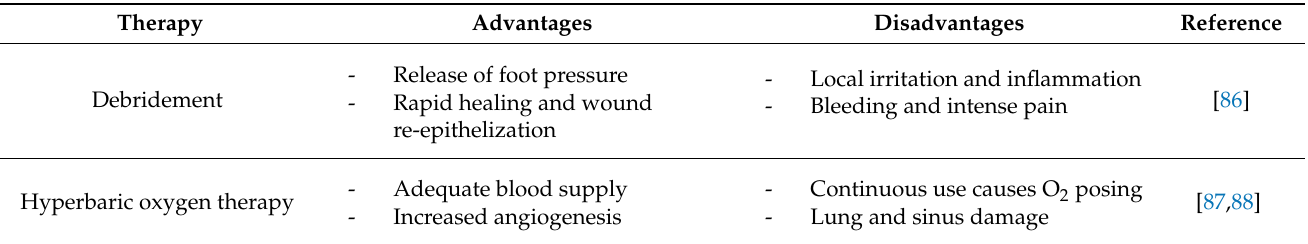
Table 1. Advantages and disadvantages of conventional